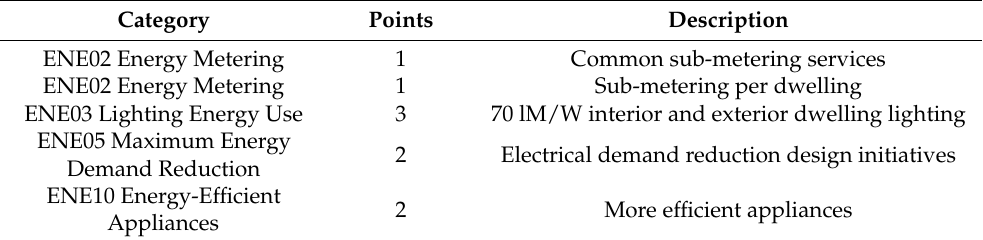
Table 9. Project scorecard Nurses Residence —Energy category.